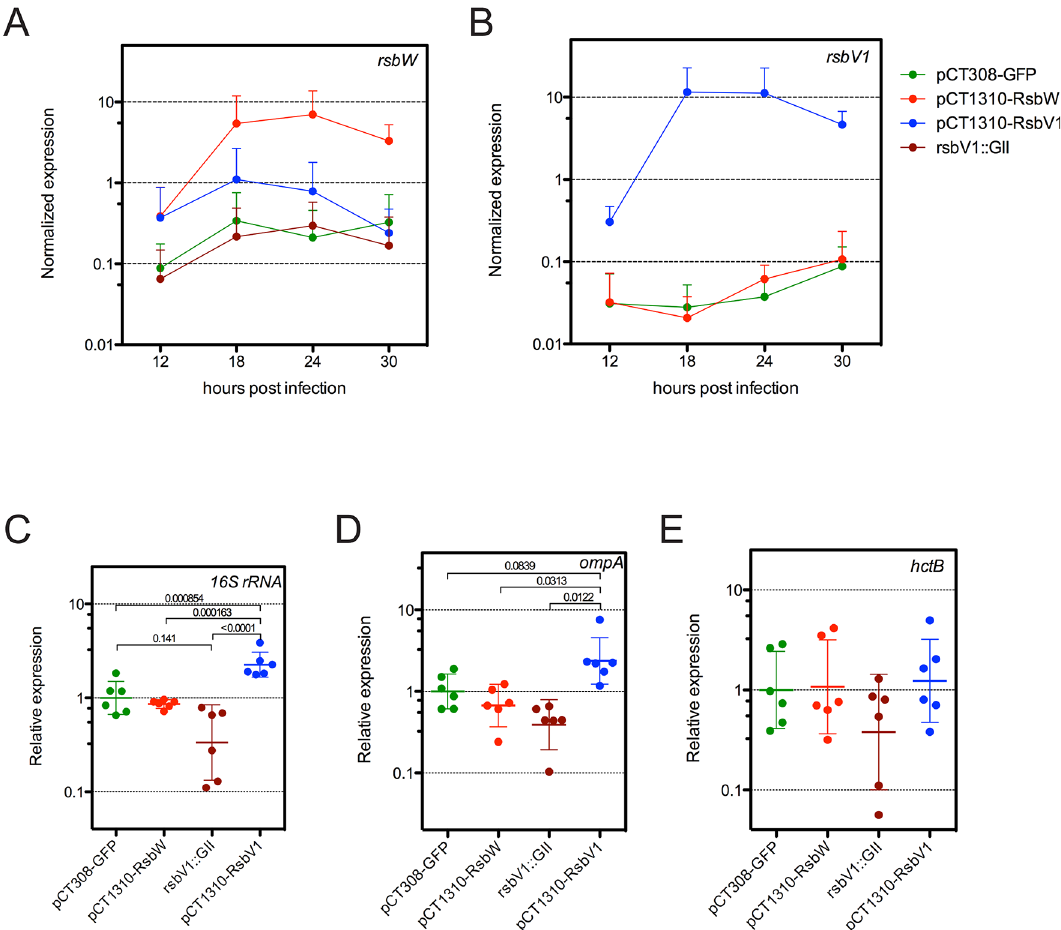
Fig 4. Analysis of σ 66 -dependent gene expression in response to modified rsb component expression. Transcripts levels of rsbW (A) or rsbV1 (B) were monitored in L2R strains harboring shuttle vector plasmids pCT308-GFP, pCT1310-RsbW, or pCT1310-RsbV1, as well as in strain DFCT15, in which rsbV1 had been inactivated via transposon insertion ( rsbV1 ::GII). The expression levels of target cassettes were elevated in their respective expression strains, whereas no rsbV1 transcription was detected in the rsbV1 ::GII strain. Expression of target cassettes are shown as the mean normalized expression as a function of time (hours post infection). Error bars represent the 95% CI. Normalized expression of 16S rRNA (C), ompA (D), and hctB (E) were calibrated to the geometric mean of the GFP-expression control. Lines indicate the geometric mean of relative expression and error bars represent the 95% CI. P- values are derived from One-way ANOVA with Tukey ’ s multiple comparisons post-test performed in R. Transcription of ompA and 16S rRNA are σ 66 - dependent [26 – 29], whereas transcription of hctB is σ 28 -dependent [30]. Only σ 66 -dependent genes experienced differential